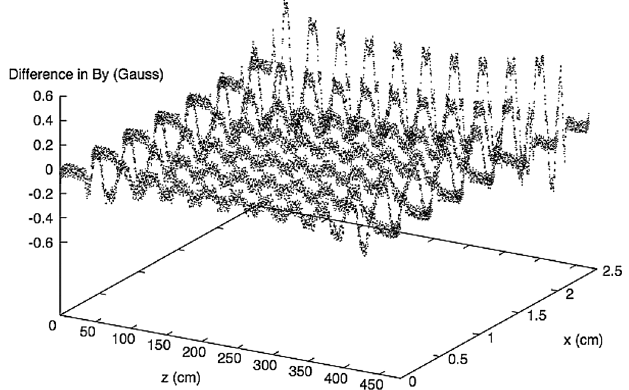
.FIG. 24. Difference (Gauss) between the vertical field B the proposed ILC wiggler and its fitted value across the midplane y ¼ 0 . The peak field is 16.7